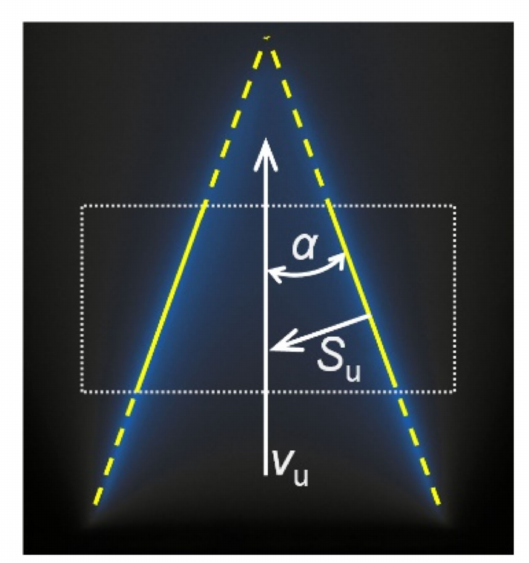
Figure 6. Relation between the laminar burning velocity ( S u ), the cone angle ( α ), and the gas flow velocity ( v u ) of a laminar premixed conical